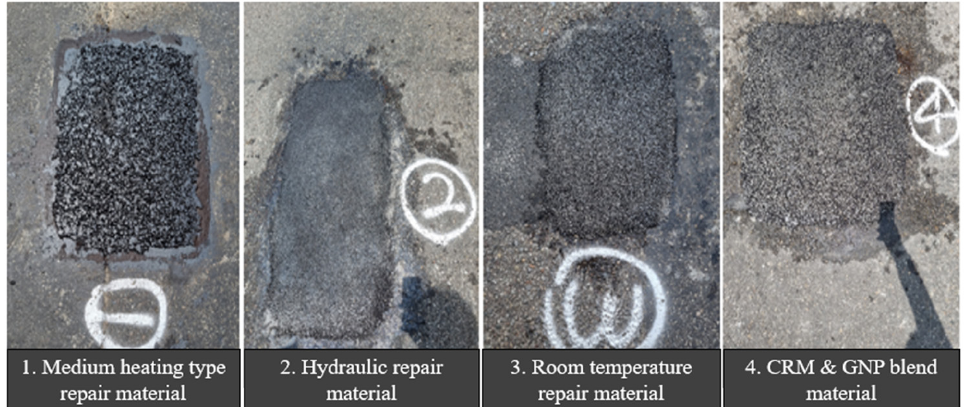
Figure 15. Appearance after construction by pavement material.